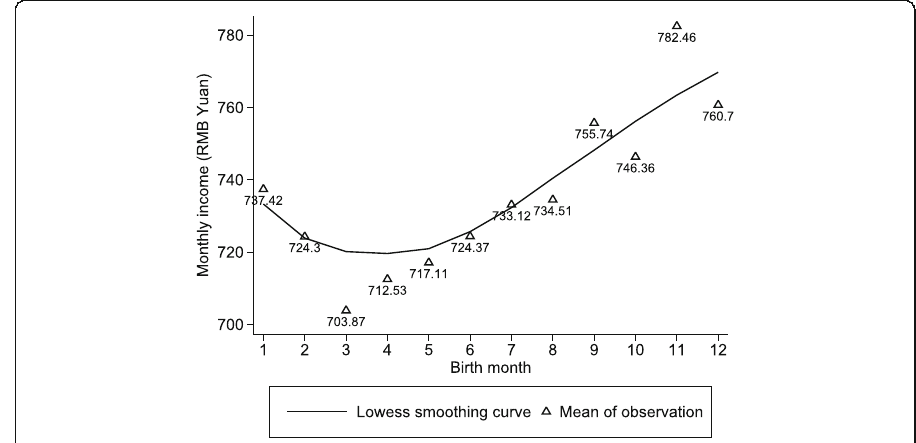
Fig. 3 Average monthly income by birth month, for birth cohorts 1979 –